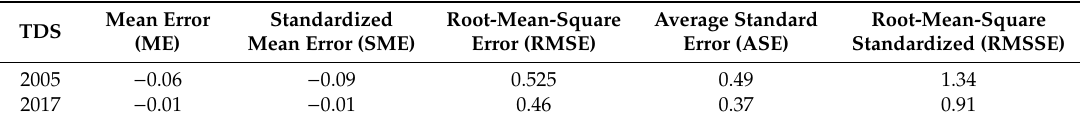
Figure 2. Semi-variogram fitting for groundwater TDS. Table 2. Error evaluation of semi-variogram of TDS.